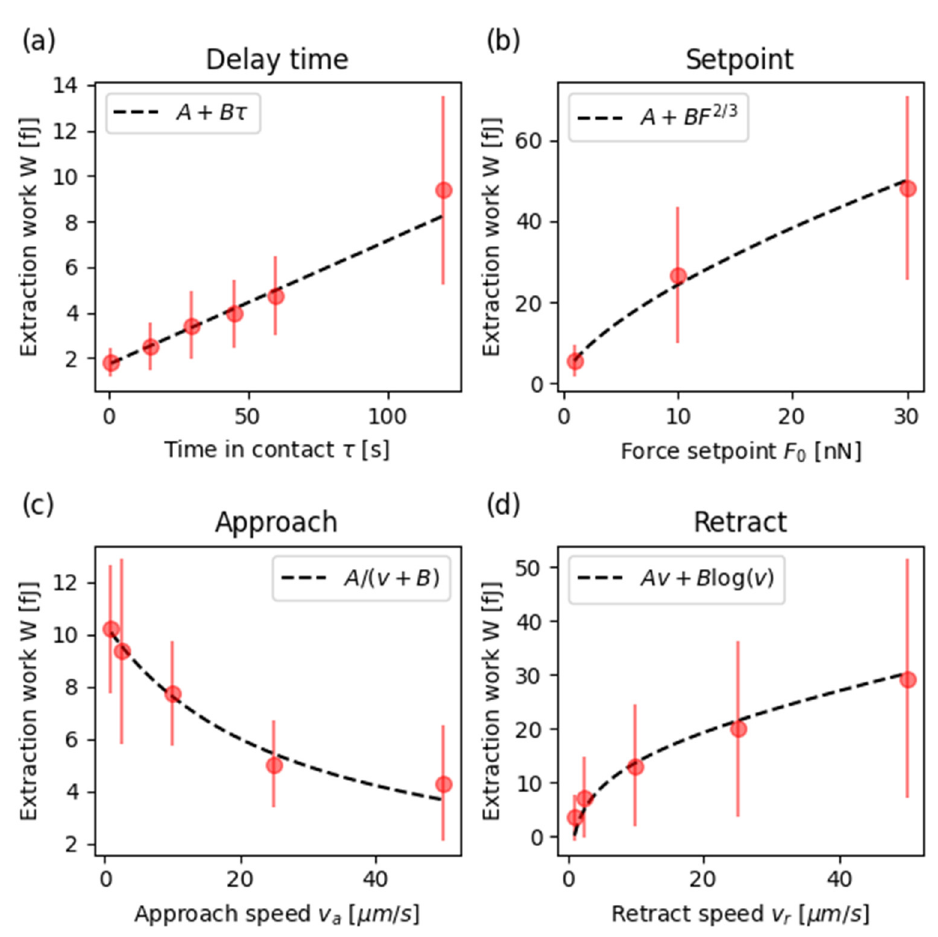
Figure 4. Average extraction work W as a function of ( a ) delay time, ( b ) force setpoint, ( c ) approach speed and ( d ) retract speed. The experimental data were fitted with the equation reported in the corresponding legend, obtaining the following parameters: ( a ) A = 0.05 fJ and a slope B = 1.72 fJ/s; ( b ) offset A = 0.42 fJ and a coefficient B = 5.13 fJ N 3/2 ; ( c ) A = 282 zJ/s and B = 27.0 µm/s; ( d ) A = 0.21 nPa s and B = 5.0 fJ.